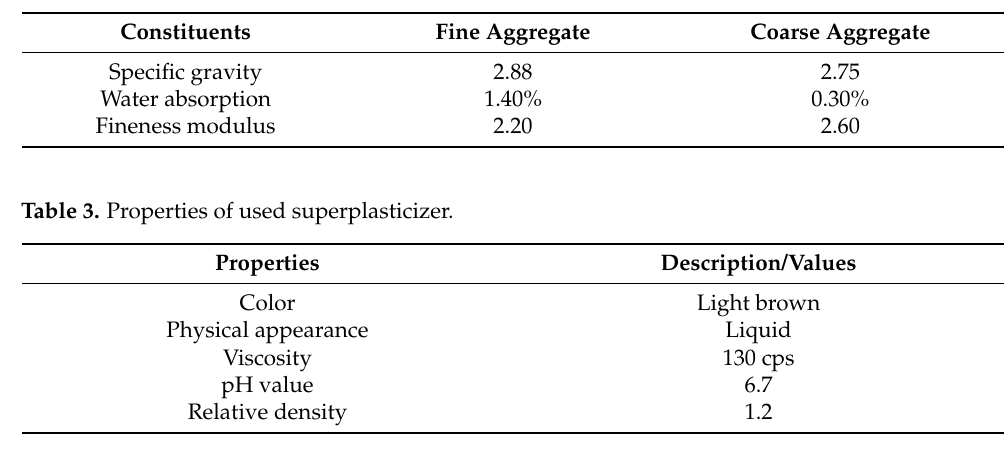
Table 2. Physical properties of used fine and coarse aggregates.